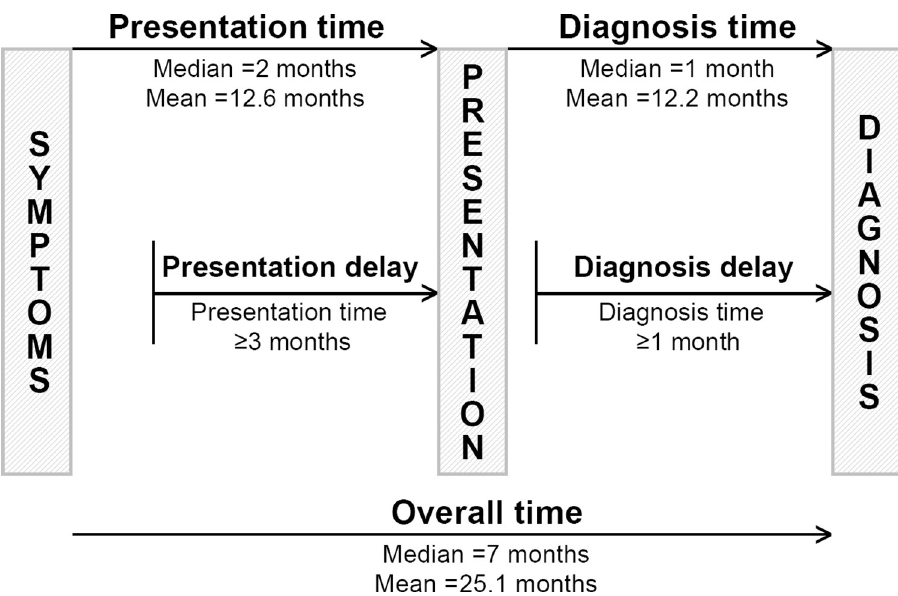
Fig 1. Timeline sketch of breast cancer presentation and diagnosis. Participants were observed to have a 2-month median presentation time and 1-month diagnosis time. The median time to diagnosis from initial symptom was 7 months. 43.3% of respondents delayed the consultation by � 3 months and 64.7% had diagnosis confirmation by � 1 month.